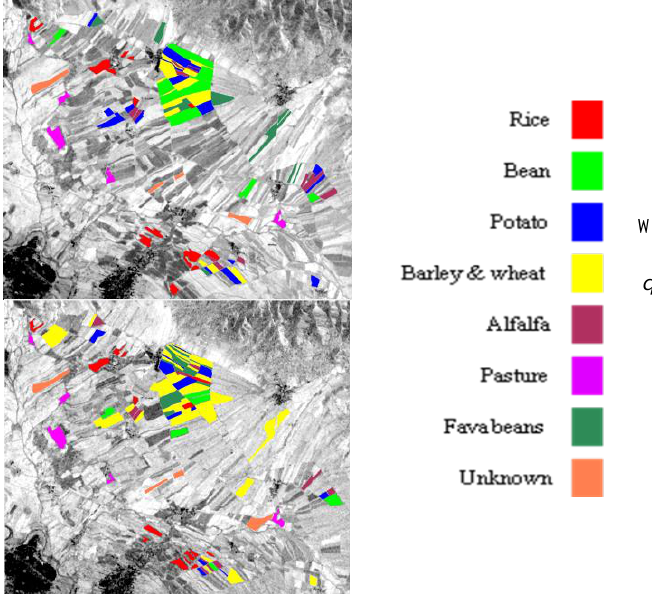
Figure 2: Reference maps for 2012 (on the top) and 2013 (on the bottom)